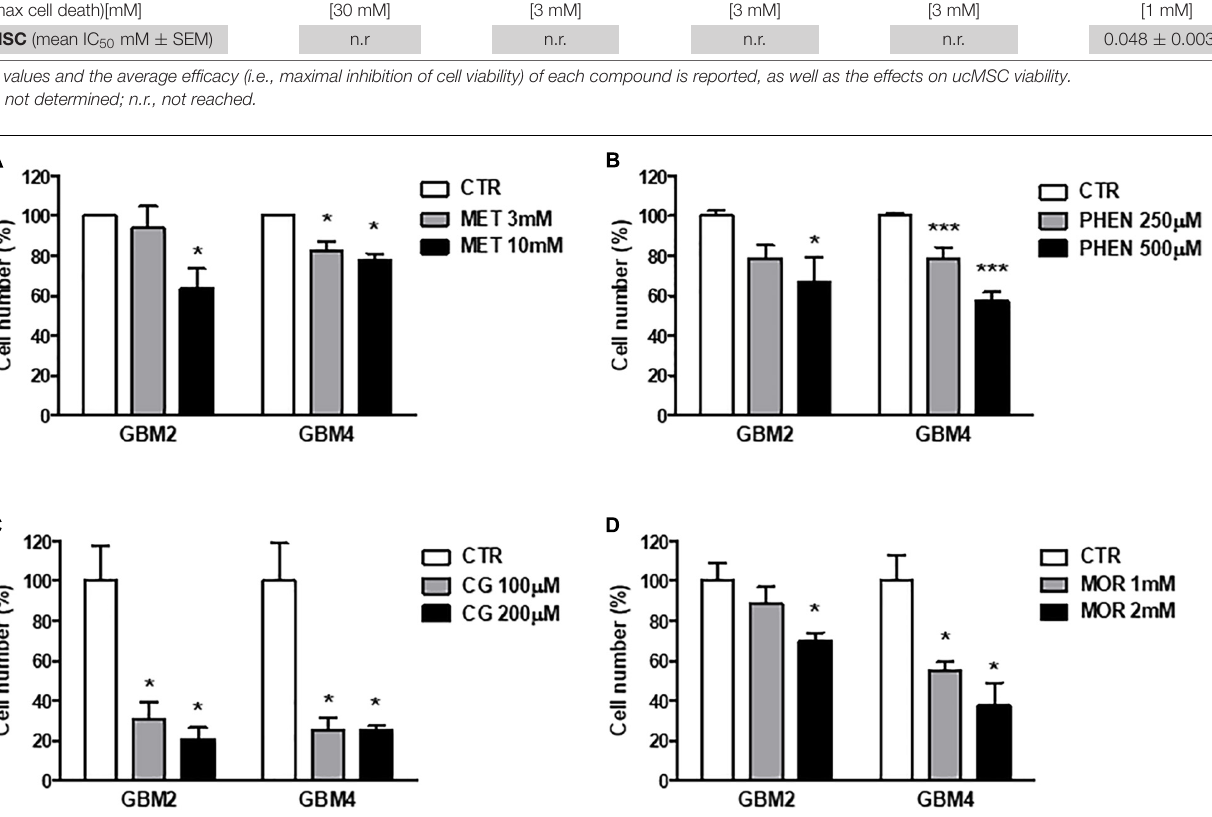
FIGURE 3 | Metformin, phenformin, cycloguanil, and moroxydine exert antiproliferative activity on glioblastoma stem cells. Inhibition of GSC proliferation by metformin (A) , phenformin (B) , cycloguanil (C) , and moroxydine (D) was evaluated by counting number of cells after 48 h of treatment with various concentrations derived from the IC 50 values, as calculated in Table 2 . Experiments were performed on both GBM2 and GBM4 cultures, and data represent the average ± SEM of n = 3 independent experiments performed in quadruplicate. ∗ p < 0.05, ∗∗∗ p < 0.001 vs. respective CTR (ANOVA, Dunnett’s post hoc